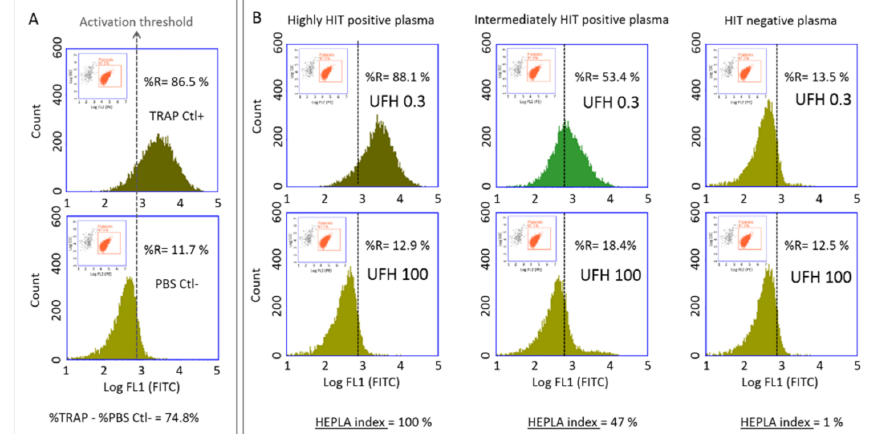
Figure 1. Dot plot: Log SSC (Side Scatter) versus Log FL2 (Filter 2) (in orange). A gate was drawn around CD41+ events, delineating the platelet population. FL1 Histogram: count versus log FL1 (in green). The gate CD41+ was applied to analyze FL1. ‘%R’ represents the percentage of CD-62p positive events. ( A ) Upper panels, TRAP-activated platelets (TRAP Ctl+); lower panels, resting platelets (PBS Ctl − ). A total of 10,000 platelets (CD41+ events) were analyzed in each run and the percentage of activated platelets (CD62p positive events) was evaluated (FL1 histogram). For each series, a cursor indicating the activation threshold was placed at the intersection of the FL1 histograms of the negative control (PBS Ctl − ) and the positive control (TRAP Ctl+) and the cut-off was determined. In this example, with resting platelets (PBS Ctl − ), we observed 11.7% CD62p- positive events corresponding to spontaneous platelet activation and electronic noise. After platelet activation with TRAP (TRAP Ctl+), we observed 86.5% CD62p-positive events corresponding to maximal platelet activation. ( B ) Left panels: Platelets activated with a highly HIT positive plasma. We observed 88.1% CD62p-positive events with 0.3 IU/mL. UFH (upper panel) and 12.9% CD62p- positive events with 100 IU/mL UFH (lower panel). The HEPLA index was 100% Middle panels: Platelets activated with intermediately HIT positive plasma. We observed 53.4% CD62p-positive events with 0.3 IU/mL UFH (upper panel) and 18.4% CD62p-positive events with 100 IU/mL UFH (lower panel). The HEPLA index was 47%. Right panels: Platelets incubated with HIT negative plasma. We observed 13.5% CD62p-positive events with 0.3 IU/mL UFH (upper panel)